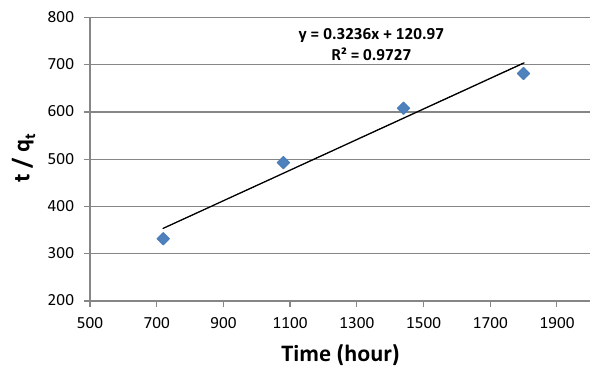
Fig. 14 q C e versus ln e for Temkin isotherm application Table 5 Constants of Temkin isotherm for the adsorption of CR dye by Aspergillus niger Parameter